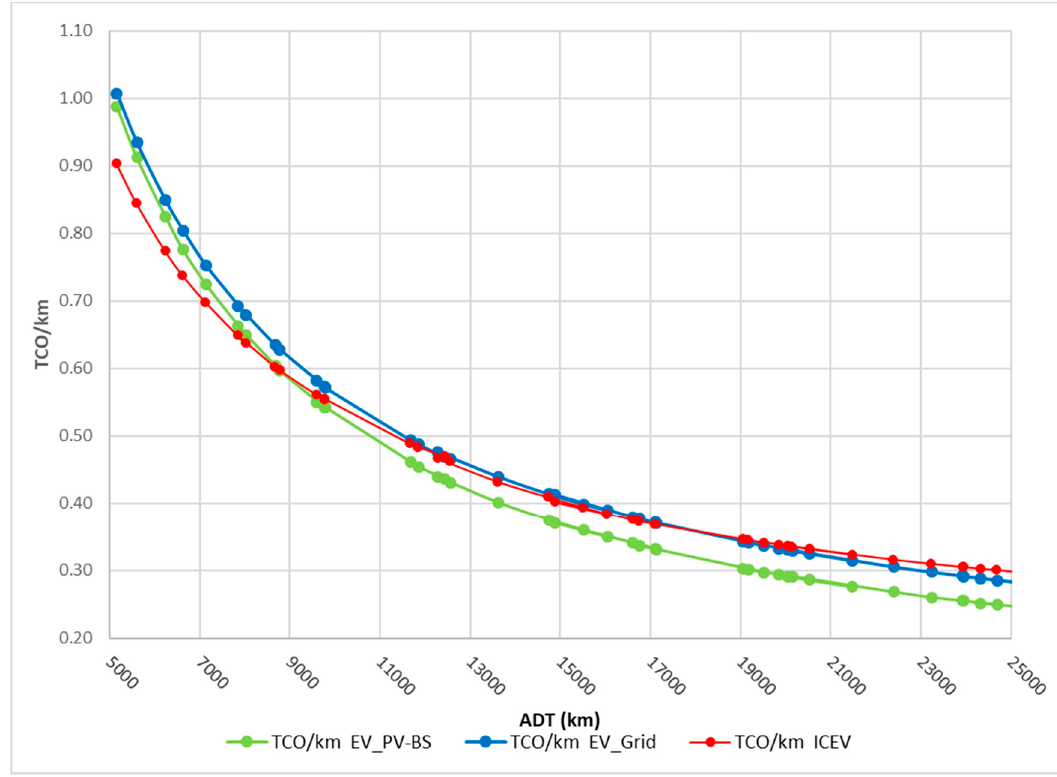
Figure 8. TCO/km in Scenario 1 with varying ADT. Figure 8. TCO / km in Scenario 1 with varying